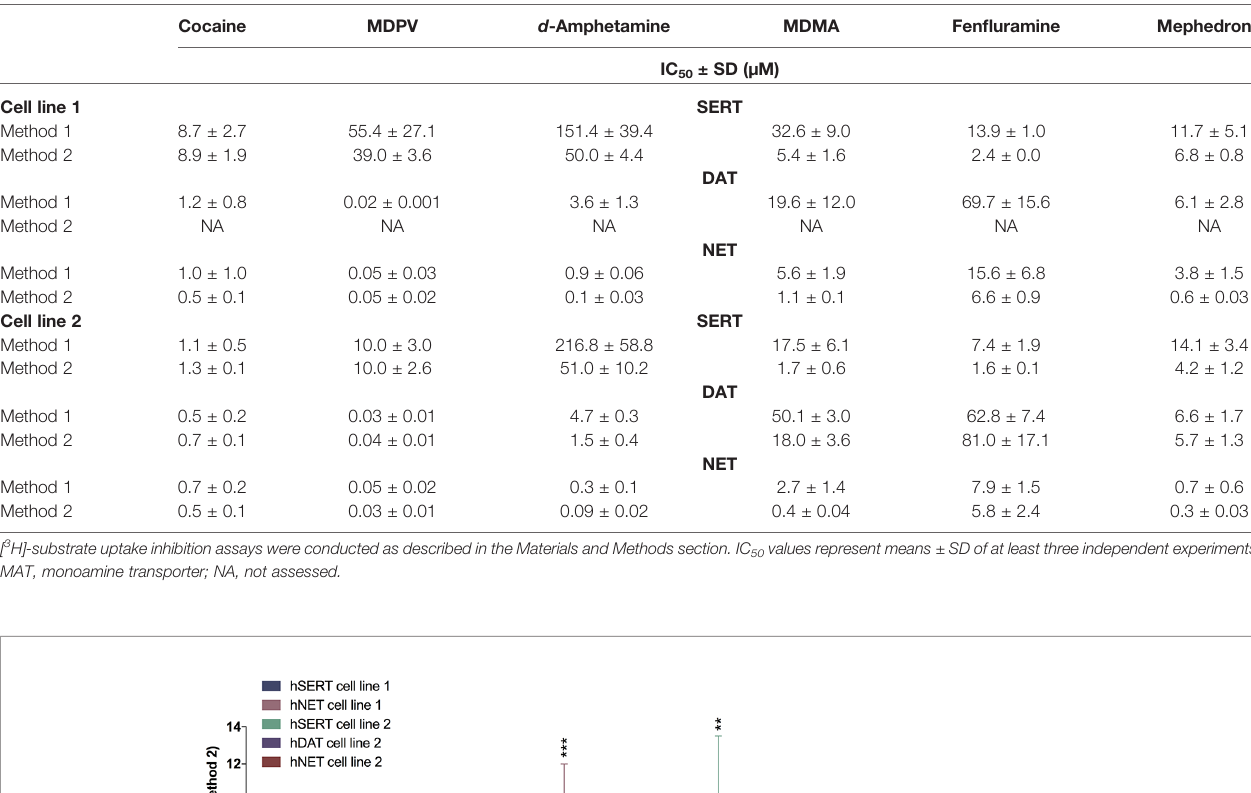
fold lower values for the method using resuspended cells. transfected cell line ( Table 2 , Supplementary Table 1 , and Supplementary Figure 1 ). The IC Fen fl uramine displayed higher potency at all transporters when 50 values for the transporter assessed with the method using resuspended cells, which was substrates d -amphetamine and MDMA were signi fi cantly statistically signi fi cant only in the case of both SERT cell lines. different for all transporters in both cell lines, with 3- to 10-